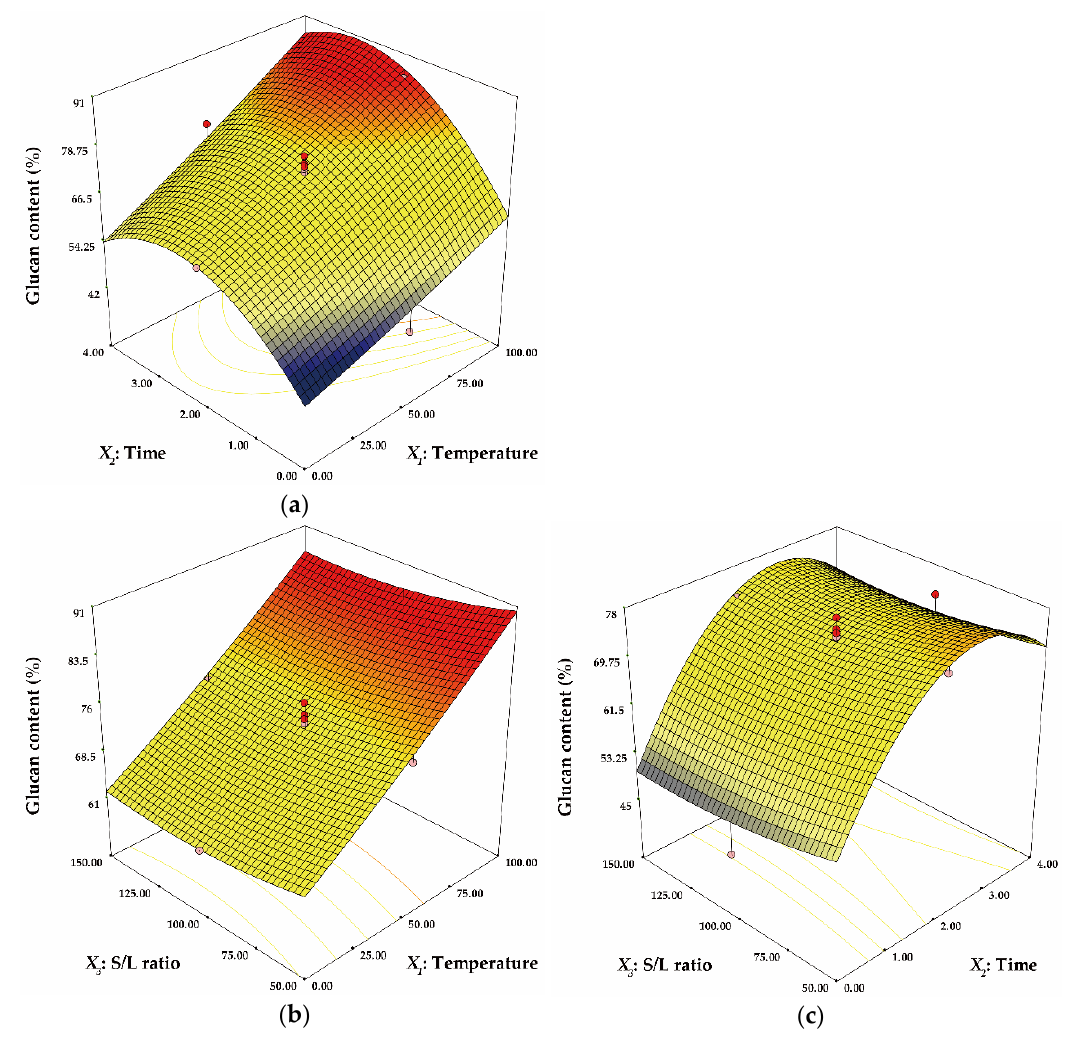
Figure 2. The three-dimensional response surface plot for the interactive effect of temperature and time ( a ), temperature and S/L ratio ( b ) and time and S/L ratio ( c ) on glucan content